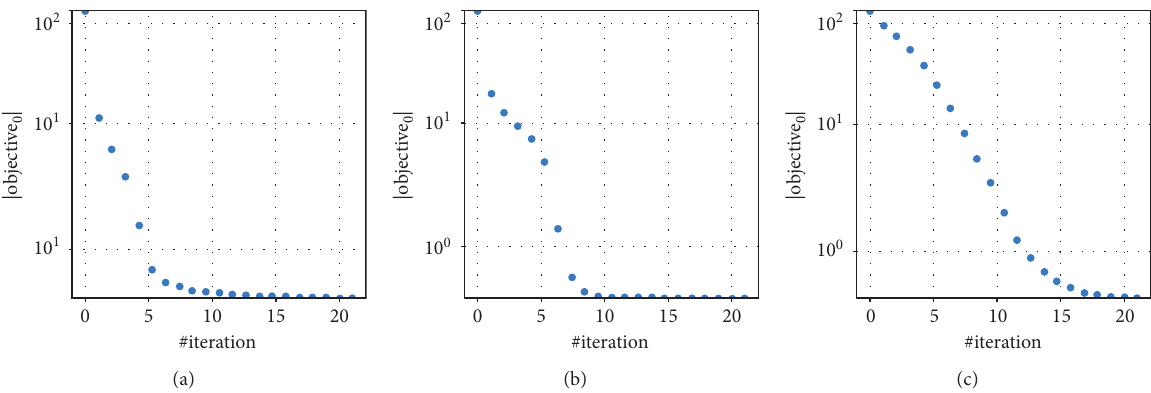
( S, T ) − U ( S, 0 )| . exact app